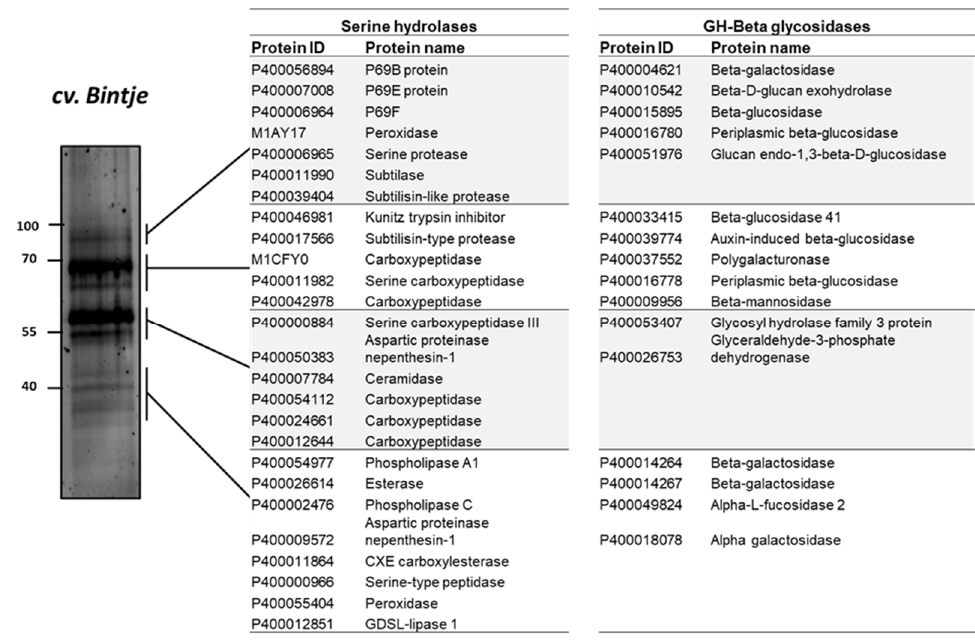
Figure 6. Identification of serine hydrolases and β -glycosidases proteins that were captured by activity-based probes. Leaf apoplastic proteome of the potato sample was co-labelled by 5 µM biotinylated probes for β -glucosidase (JJB111) and serine hydrolases (FP-biotin). Biotinylated proteins were then affinity-purified with streptavidin beads and separated on 12% sodium dodecyl sulfate- polyacrylamide electrophoresis gel. The gel was stained by SYPRO Ruby staining.